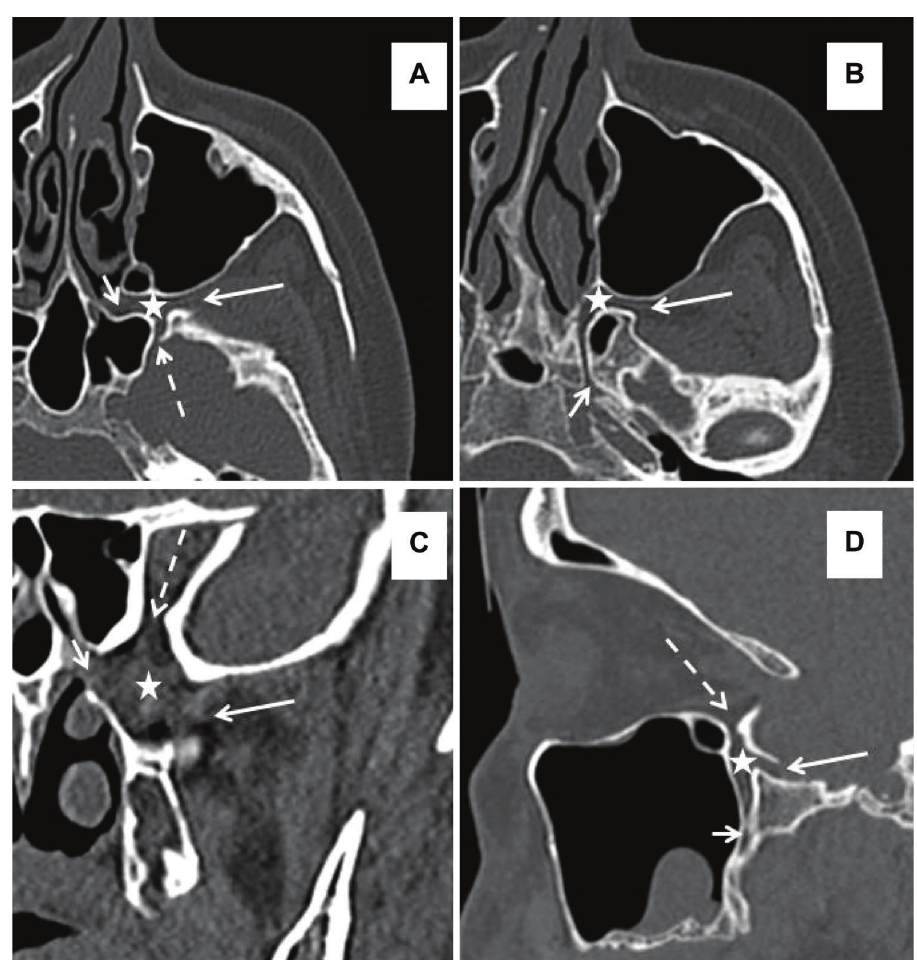
Figure 1 - CT anatomy of the pterygopalatine fossa ( asterisk ). (A) An axial image showing a communication to the ITF via the pterygomaxillary fissure (long arrow ) to the middle cranial fossa via the foramen rotundum (dashed arrow) and to the nasal cavity via the sphenopalatine foramen (short arrow) . (B) An axial image in a different plane showing the Vidian canal running to the foramen lacerum (short arrow) . (C) A coronal image showing a communication to the nasal cavity via the sphenopalatine foramen (short arrow) to the orbit via the infraorbital fissure (dashed arrow) and to the ITF via the pterygomaxillary fissure (long arrow ). (D) A sagittal image showing the greater palatine canal (short arrow) running to the oral cavity with a communication to the orbit via the infraorbital fissure (dashed arrow) and to the middle cranial fossa via the foramen rotundum (long arrow)